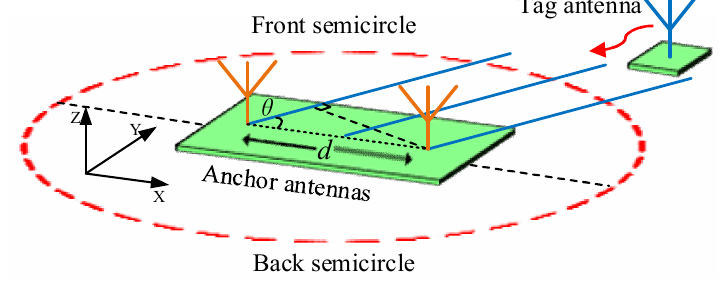
Figure 1. Configuration of a PDOA-based localization system.